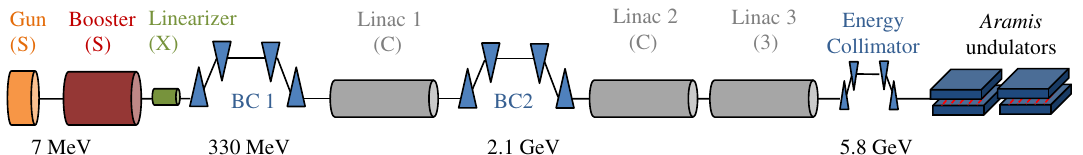
FIG. 2. SwissFEL layout (see text for more